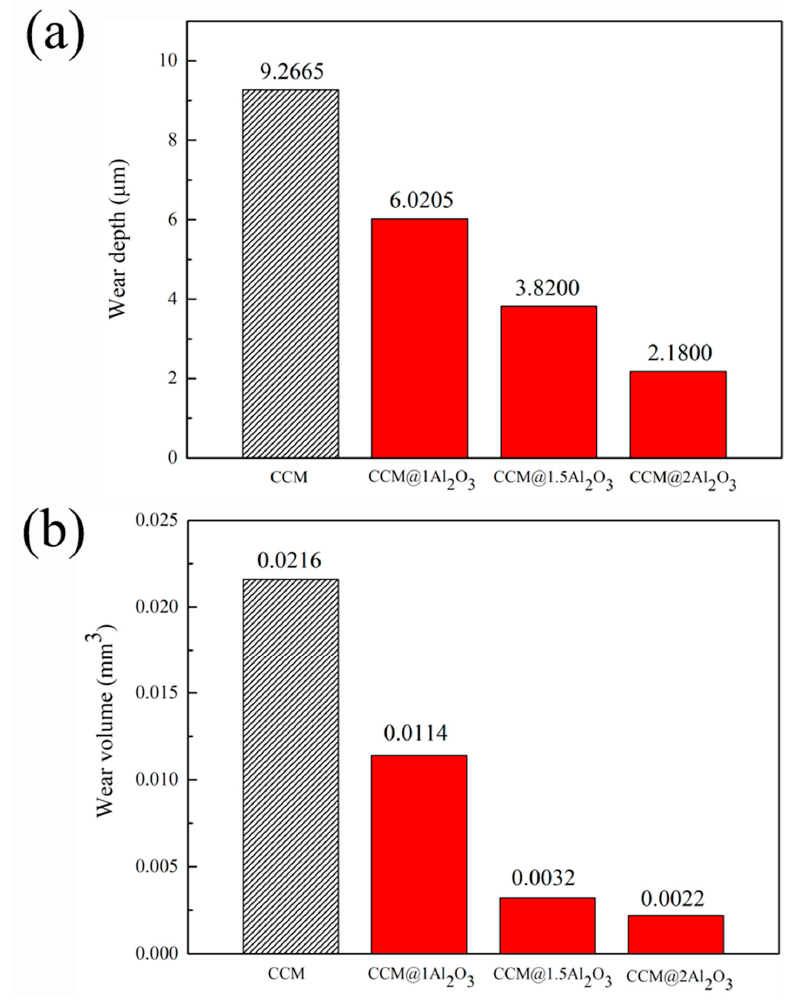
Figure 11. Friction data of the LPBF-processed parts: ( a ) wear depth; ( b ) wear